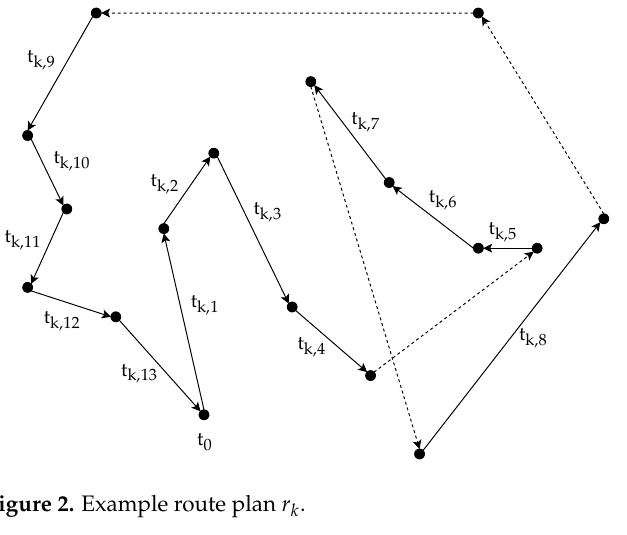
Figure 2. Example route plan r k .